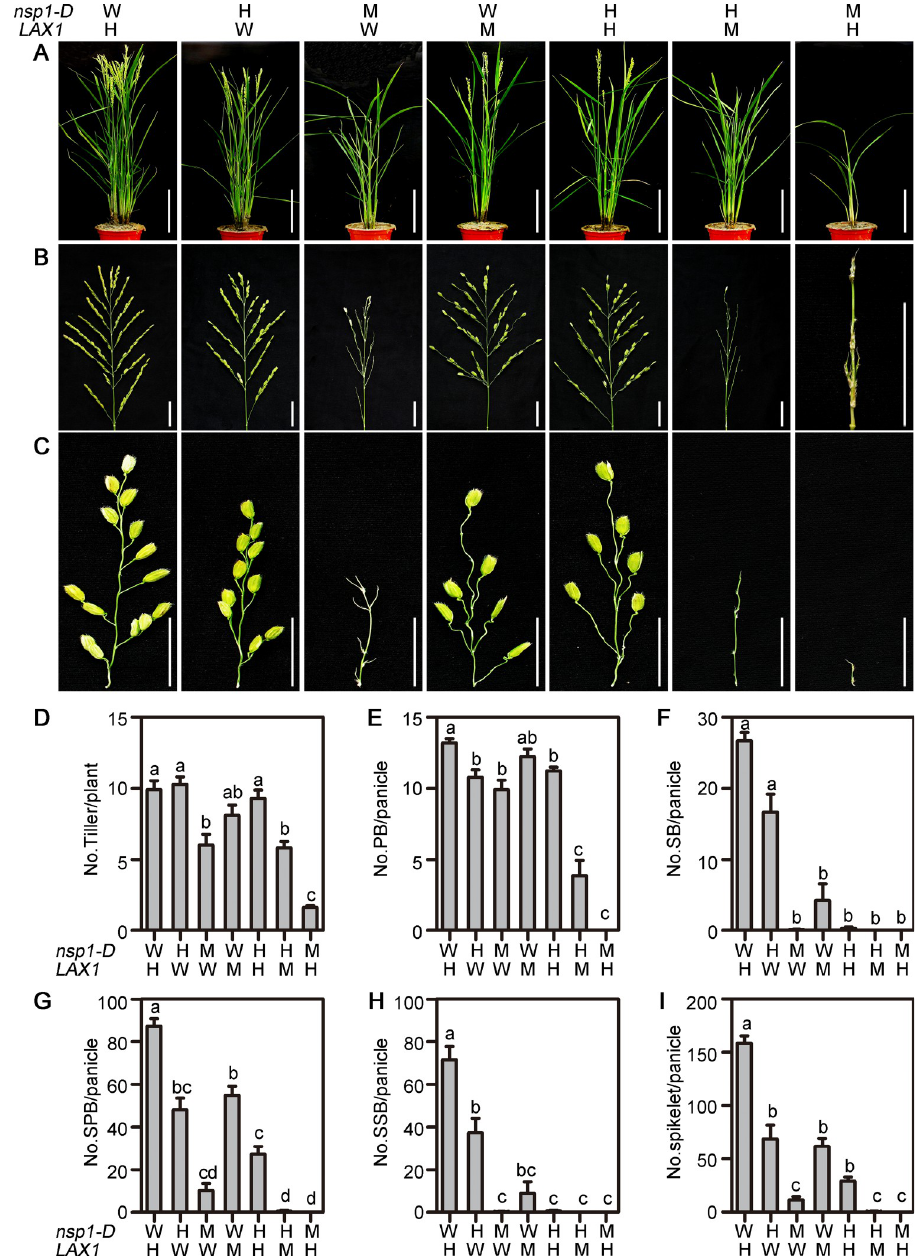
Fig 6. Phenotype analysis of plants in the progenies of nsp1-D/+ lax1/+ . (A) to (C) Architectures of (A) the plant, (B) panicle, and (C) primary branch (PB) in the progeny. (D) to (I) Quantitative statistics of the number of (D) tillers, (E) PBs, (F) secondary branches (SBs), (G) spikelets of PBs (SPBs), (H) spikelets of SBs (SSBs) and (I) total spikelets in the progeny. Data are the means ± SEM from 10 replicates. Different letters denote significant differences ranked by the Dunnett’s test (one-way analysis of variance, P < 0.05). WH, NSP1 lax1/+ ; HW, nsp1-D/+ LAX1 ; MW, nsp1-D LAX1 ; WM, NSP1 lax1 ; HH, nsp1-D/+ lax1/+ ; HM, nsp1-D/+ lax1 ; MH, nsp1-D lax1/+ . Bars = 20 cm in (A) and 3 cm in (B, C).